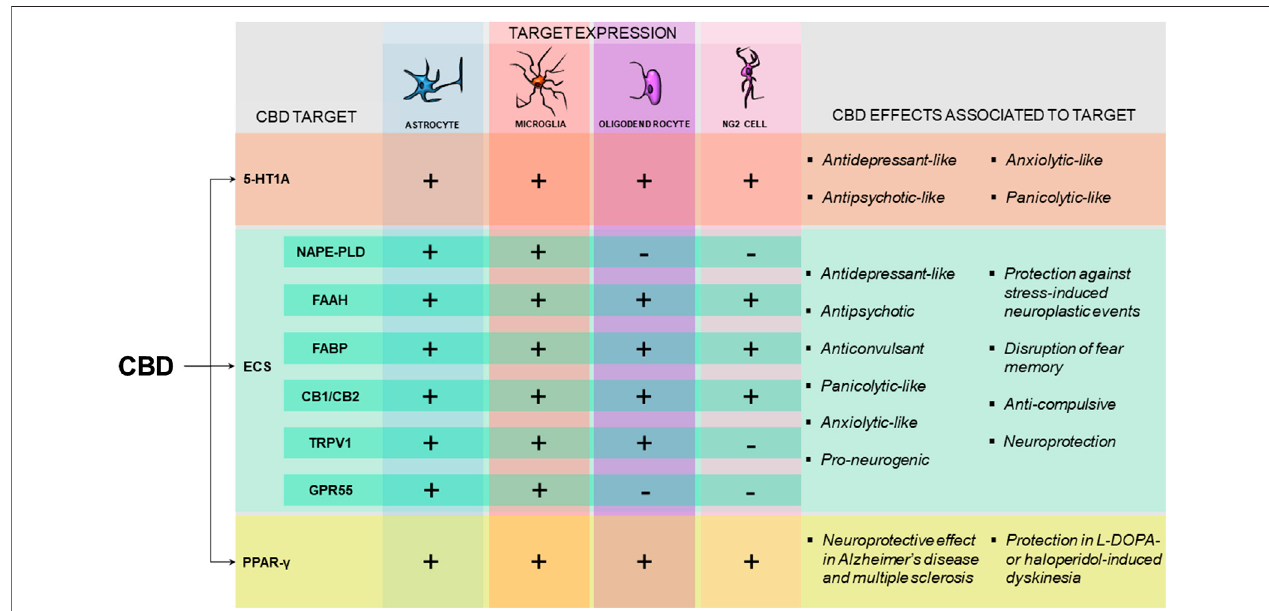
FIGURE 1 | Pattern of expression and effects associated with the molecular targets potentially involved in CBD mechanism of action in glial cells. Schematic representation pointing the expression of 5-HT1A receptor, proteins of the endocannabinoid system (ECS) and the PPAR- γ receptor in astrocytes, microglia, oligodendrocytes andNG2cells(Azmitiaetal.,1996;Bernardoetal.,2000;Egertová etal.,2003;Zhangetal.,2011;Gonzalez-Reyesetal.,2013;Graves,2013;Shari fi etal.,2013;Youngetal.,2013;Keetal.,2014;FanandAgid,2018;Duffyetal.,2017;Viudez-Martínezetal.,2018;Kongetal.,2019;Yangetal.,2019;Dingetal., 2020)(+)indicates thatthereisevidence thattheprotein hasbeen foundinthespeci fi ccelltype ( − ) indicates theabsenceofevidence fortheexpression ofthe molecular targetinthespeci fi ccelltype.FortheECS,NAPE-PLD,FAAHandFABPareconsideredasthepotentialtargetsinvolvedintheincreasedAEAavailabilityinducedbyCBD treatment.TheeffectsofCBDthathavebeenshowntobedependenton5-HT1A(CamposandGuimarães,2008;Zanelatietal.,2010;Camposetal.,2013a;Rodrigues da Silva et al., 2020), on the ECS (Casarotto et al., 2010; Leweke et al., 2012; Stern et al., 2012; Campos et al., 2013b; Pazos et al., 2013; Sartim et al., 2016; Fogaça et al., 2018; Khan et al., 2020) or on PPAR- γ receptors (Esposito et al., 2011; dos-Santos-Pereira et al., 2016; Giacoppo et al., 2017; Sonego et al., 2018) are highlighted. CBD , Cannabidiol; 5-HT1A , 5-hydroxytryptophan 1 A receptor; ECS , endocannabinoid system; NAPE-PLD , N-acyl phosphatidylethanolamine-speci fi c phospholipaseD; FAAH ,fatty-acidamidehydrolase; FABP ,fattyacidbindingprotein; CB1/CB2 ,cannabinoidreceptor one/cananbinoid receptortwo; TRPV1 ,transient receptor potential vanilloid one; GPR55 , G coupled receptor 55; PPAR- γ , Peroxisome proliferator-activated receptor- γ